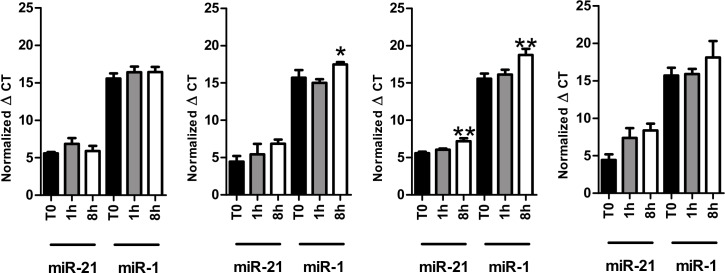
Impact of physical disturbance.Whole blood was collected into EDTA or serum separator containing tubes and incubated on a shaker at 30 rpm at room temperature for 0h, 1h, and 8h before processed into plasma (A) and serum (B) or processed into plasma (C) and serum (D) immediately and then incubated on a shaker at 30 rpm at room temperature for 0 h, 1 h, and 8 h. Data presented as normalized average ΔCTvalues±SEM. *p<0.05, **p<0.01, One-way ANOVA with Dunnet post test.